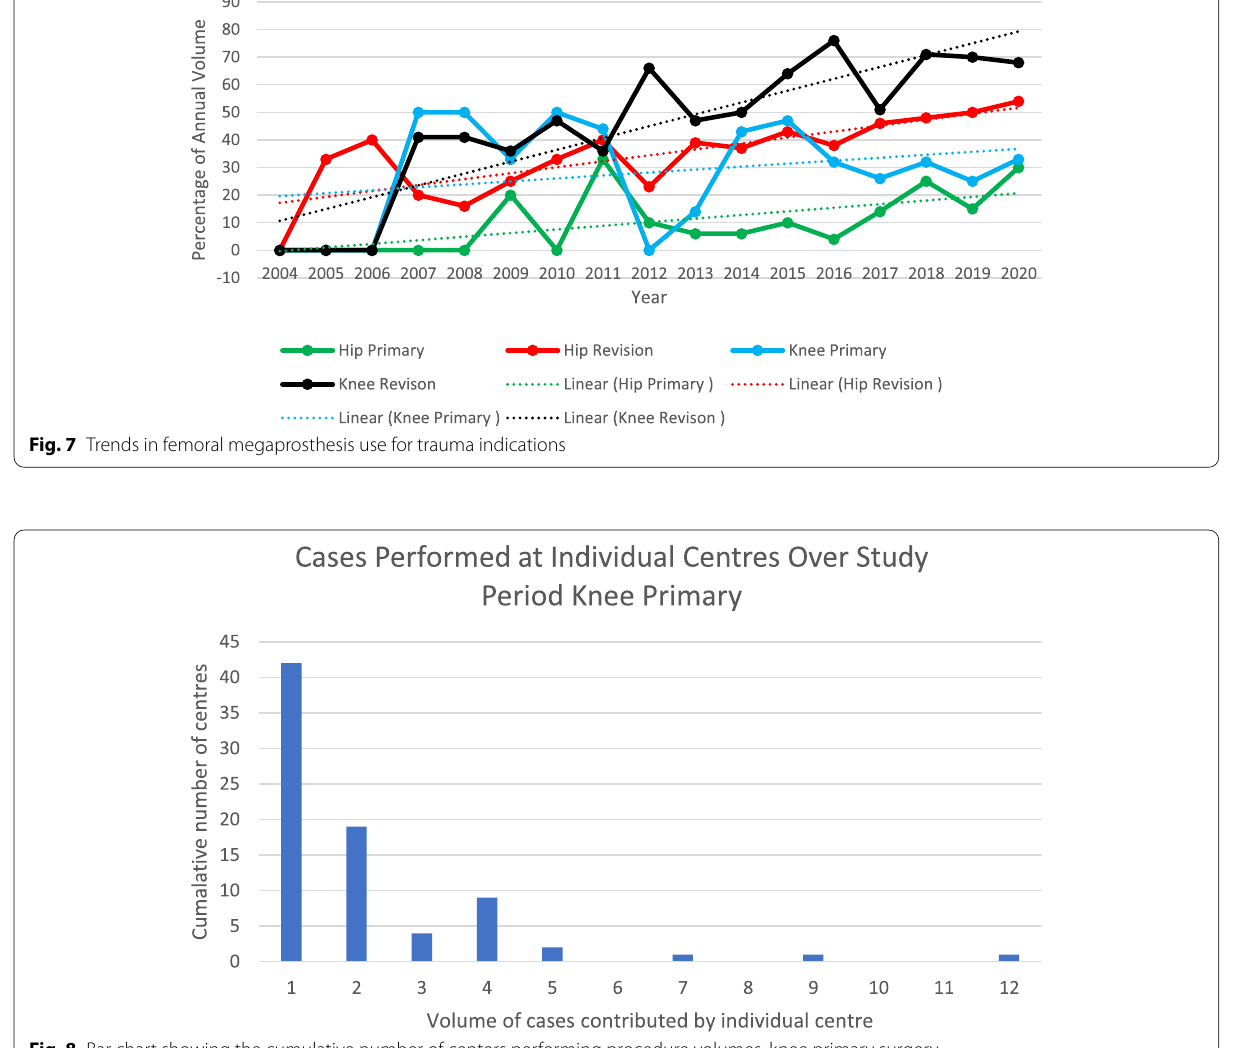
Fig. 8 Bar chart showing the cumulative number of centers performing procedure volumes, knee primary